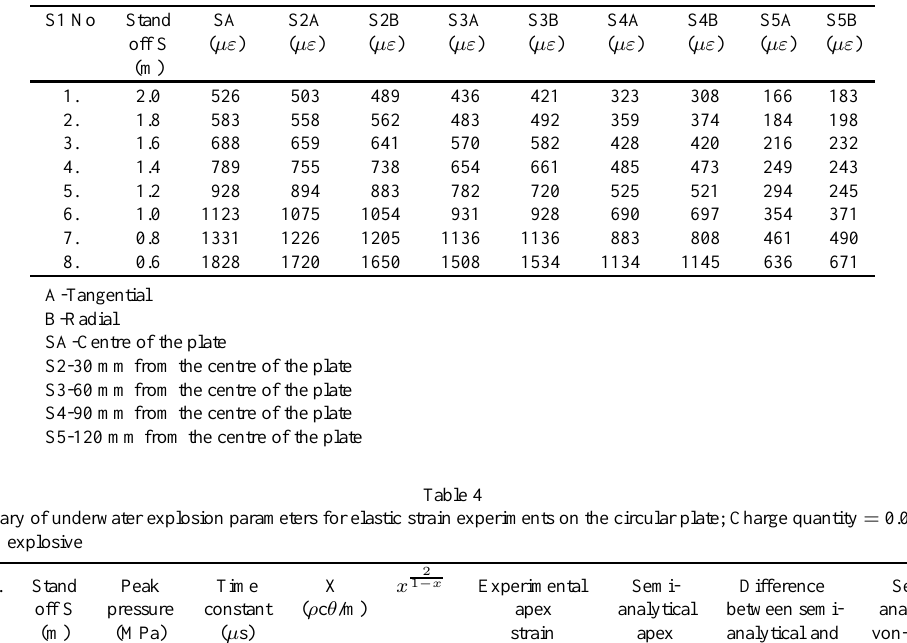
Table 3 Summary of results of dynamic elastic strain experiments on the circular plate; Charge quantity =